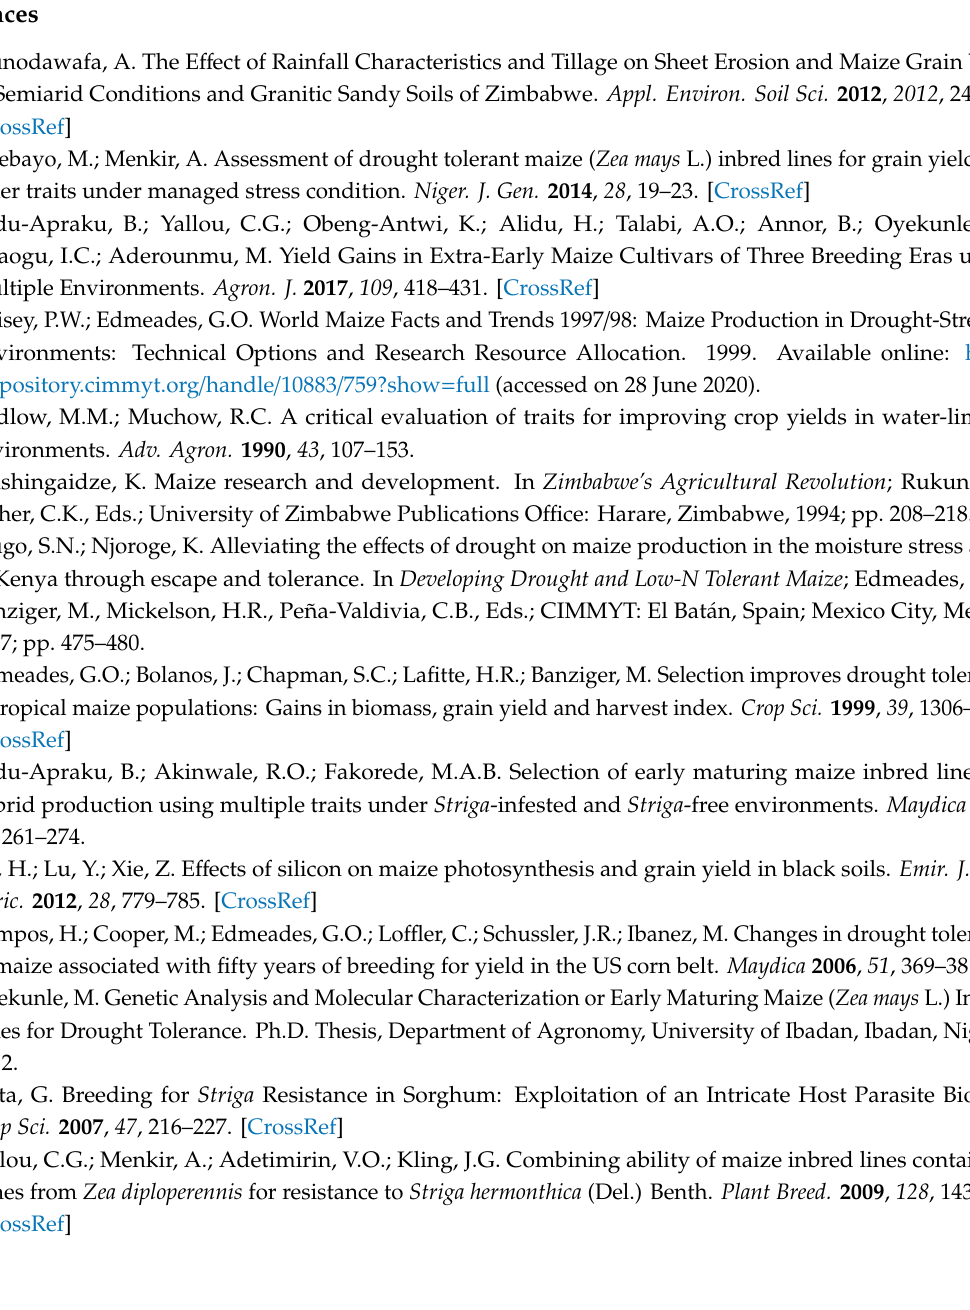
Table S1: General combining ability (GCA) e ff ects of 65 early-maturing maize inbred lines under Striga -infested and drought environments in Mokwa (2016, 2017) and Abuja (2016), Table S2: General combining ability (GCA) e ff ects of 61 early-maturing maize inbred lines under optimal environments at Ikenne (2016, 2017), Mokwa (2016), and Abuja